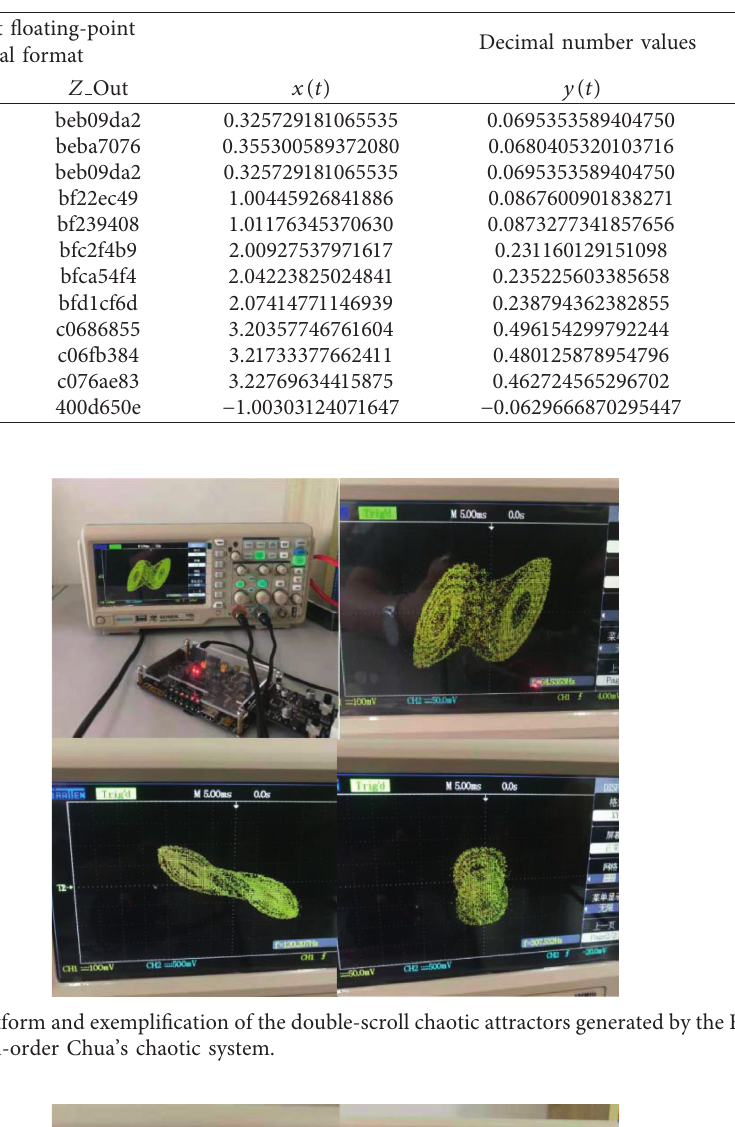
Table 4: The conversion result from 32-bit floating-point number output by FPGA to decimal number.